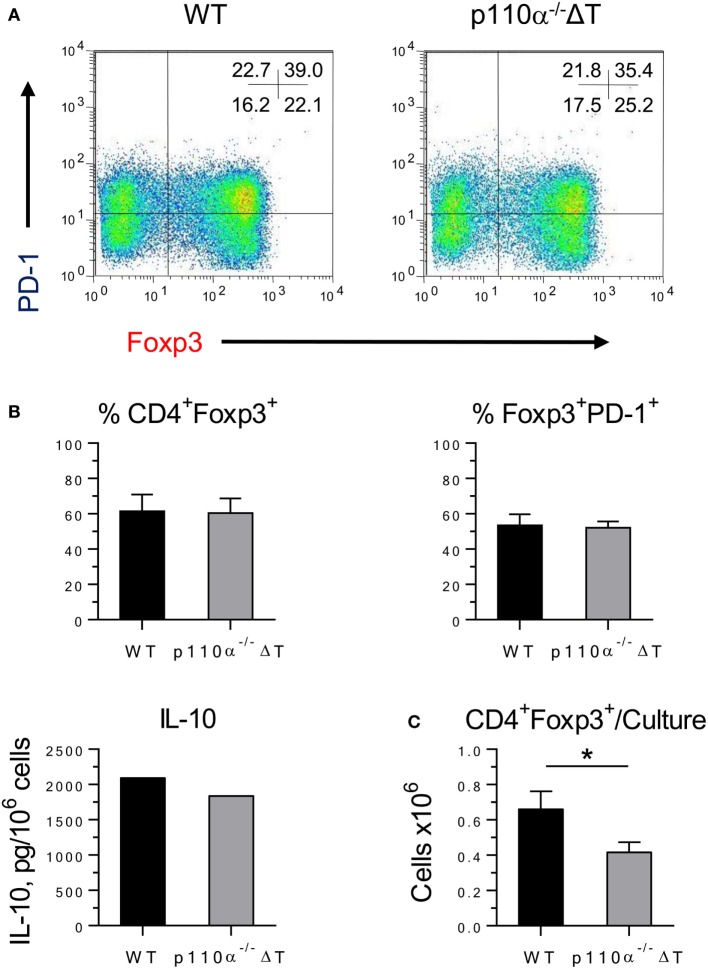
Differentiation of iTreg in WT or PI3-kinase p110α deficient (p110α−/−ΔT) CD4+ T cells. (A) Naive CD4+ T lymphocytes were cultured for 48 h under conditions favoring Treg differentiation. The percentage of iTreg (CD4+Foxp3+) cells and the expression of PD-1 were analyzed by flow cytometry. Figures inside the histograms represent the percentage of cells in each quadrant. Data from one representative experiment of four performed. (B) Percentage of iTreg (Foxp3+ cells in CD4+ cells); PD-1+ cells in Foxp3+ cells; and IL-10 in culture supernatants. (C) Number of iTreg cells/culture in naive CD4+ T lymphocytes from WT or p110α−/−ΔT mice cultured under Treg conditions. Mean from four experiments ± SE. IL-10, mean from two experiments with similar results. Asterisks indicate significant differences (*p < 0.05) between groups, as determined by the Student’s t-test.